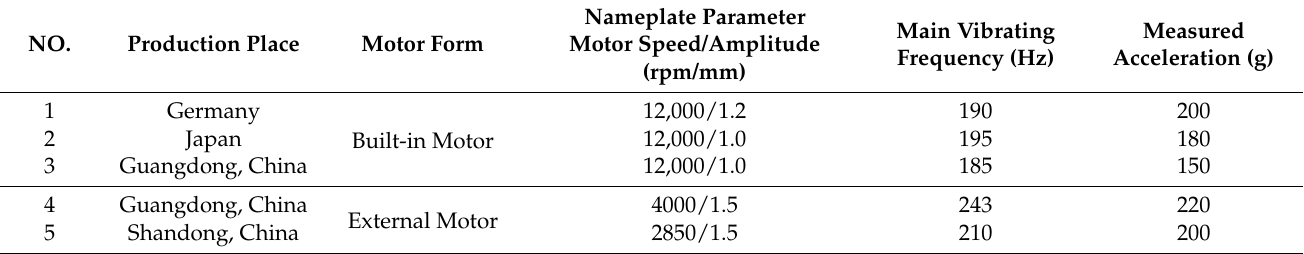
Table 1. Vibrating rod parameters.